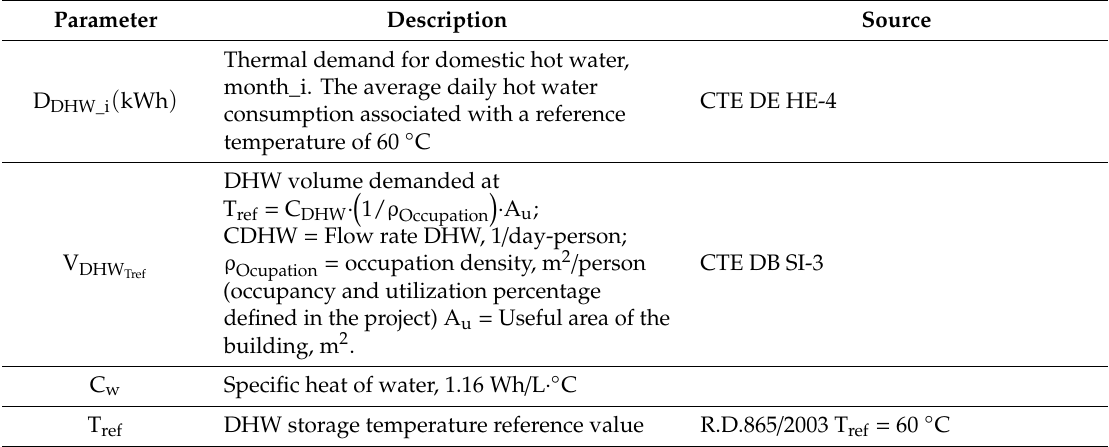
Table A5. Parameters for domestic hot-water